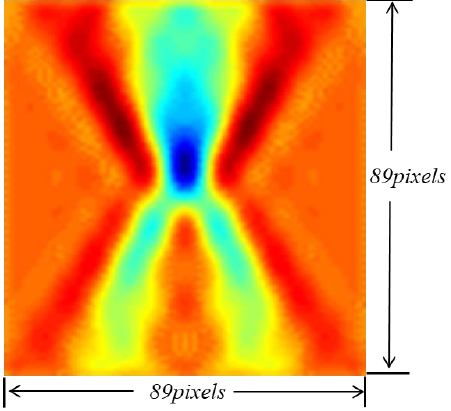
Figure 9. Each TSOM image with a size of 89 × 89 pixels.